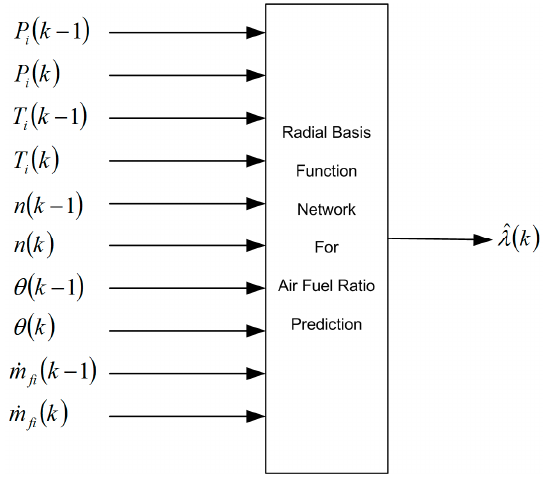
Figure 6. The structure of AFR soft sensor by RBFN. Energies 2017 , 10 , 131